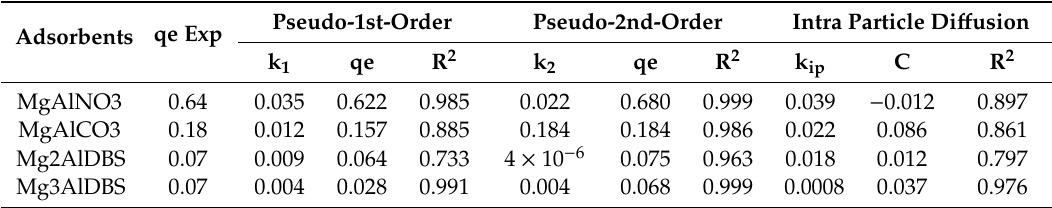
Table 2. Kinetic parameters of pseudo-first-order, pseudo-second-order and intra-particle di ff usion models for amaranth adsorption by MgAlNO3, MgAlCO3, Mg2AlDBS and Mg3AlDBS. Adsorbents qe Exp